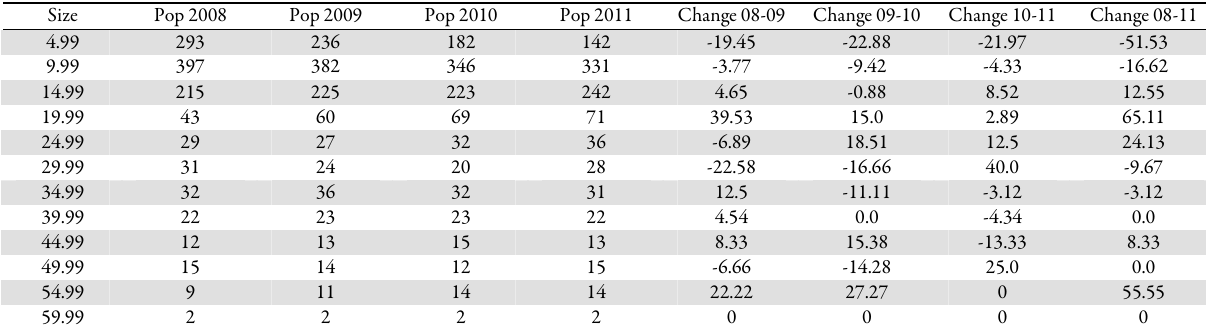
Tab. 3. Size class specific population changes in Kagekanu permanent vegetation plot